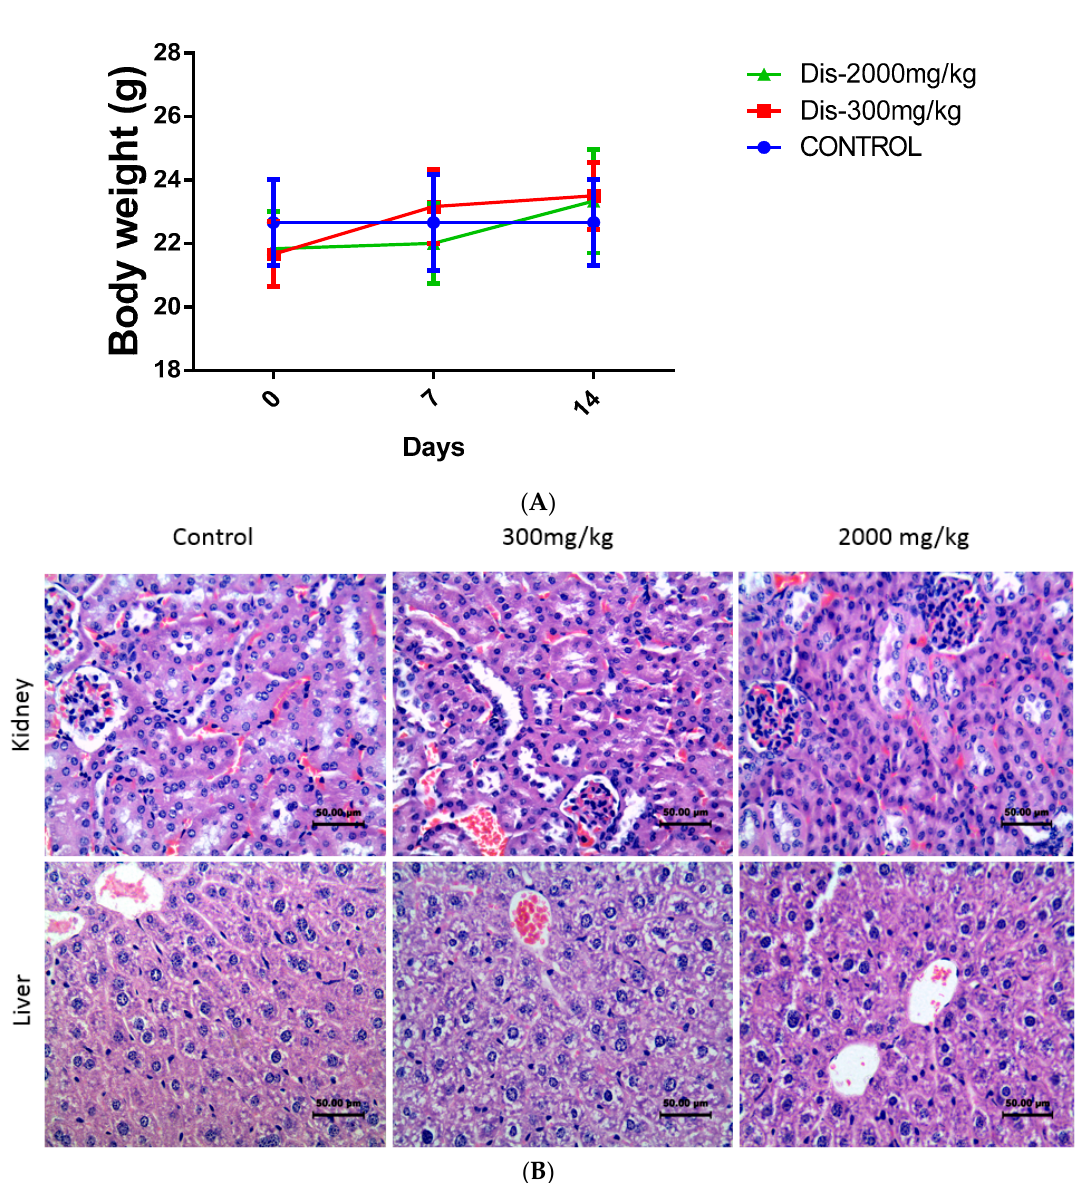
Figure 1. Toxicity e ff ect of Dis in female ICR mice. ( A ) Body weight changes of mice between treated mice and untreated control during 14 days. Data were expressed as mean ± standard deviation. ( B ) Toxicity e ff ect of Dis on histological sections of liver and kidney of mice. Mice were treated with single dose of vehicle (control) or Dis (300 and 2000 mg / kg). Kidney and liver of ICR mice were harvested after 14 days and stained with Hematoxylin and Eosin (H&E) staining. No sign of kidney or liver tissues damage or abnormalities were observed in treated and control groups. (Magnification ×40).